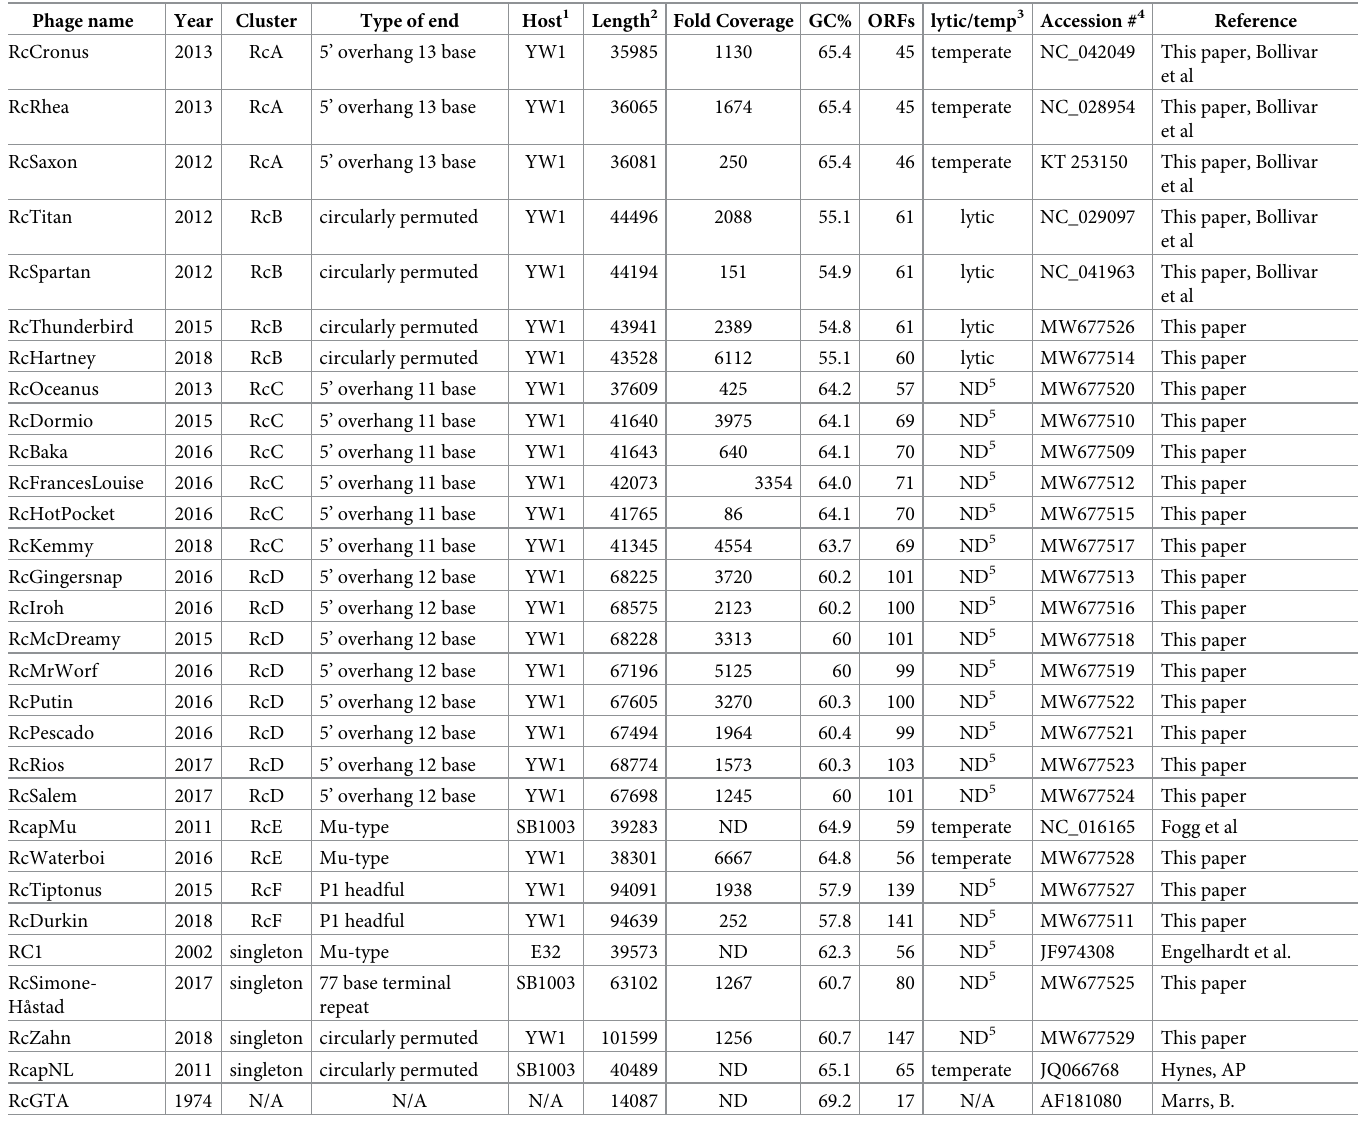
Table 3. Genometrics of R . capsulatus phages and